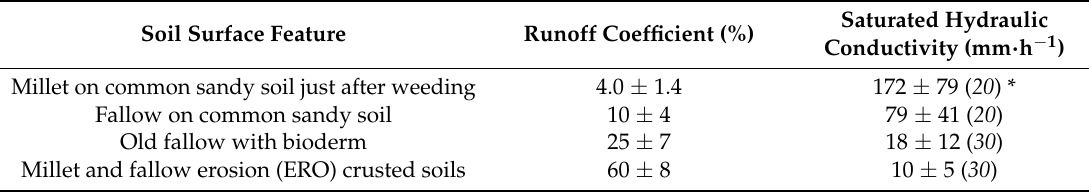
Table 3. Comparison of the hydrodynamic properties of non-crusted and crusted soils [2]. Soil Surface